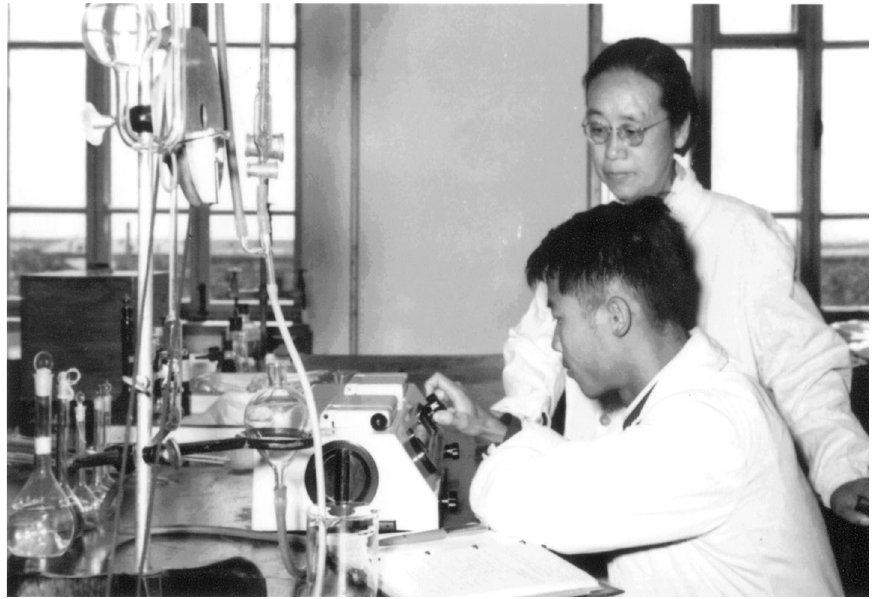
Figure 2. Professor Weisun Tao was guiding student in the